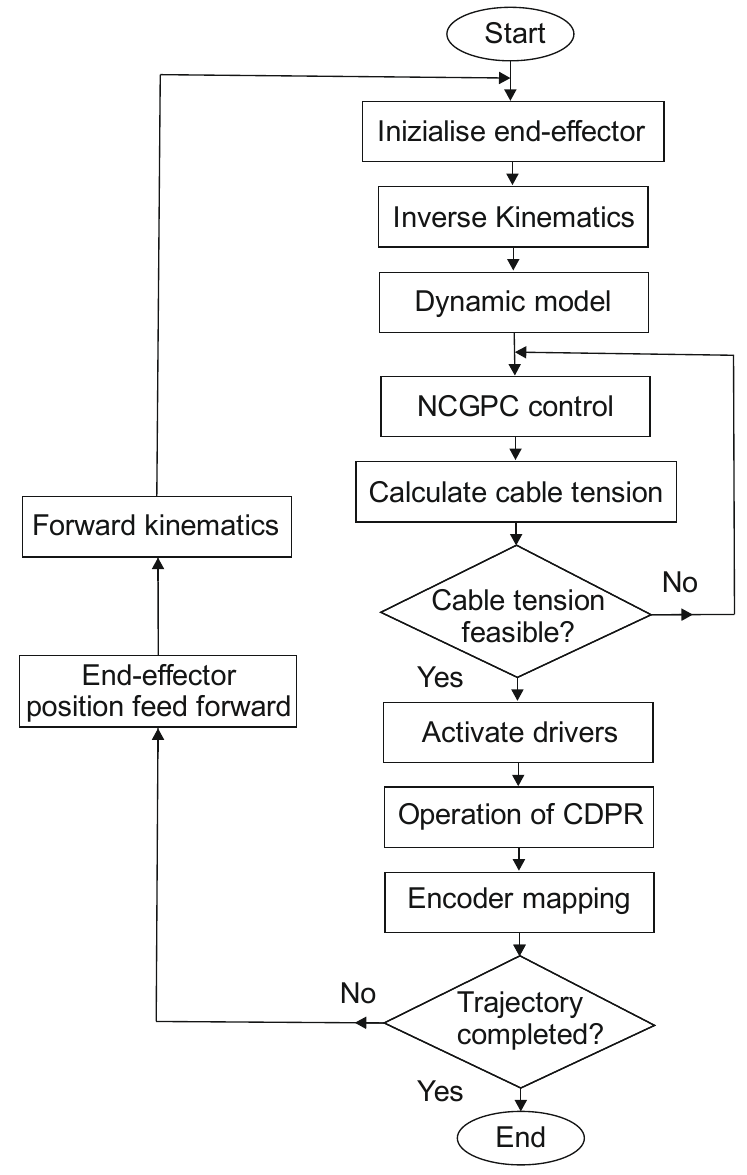
Figure 2. A flow-chart of tension control (NCGPC: nonlinear continuous time generalized predictive control; PDP robots: planar-driven parallel robots).